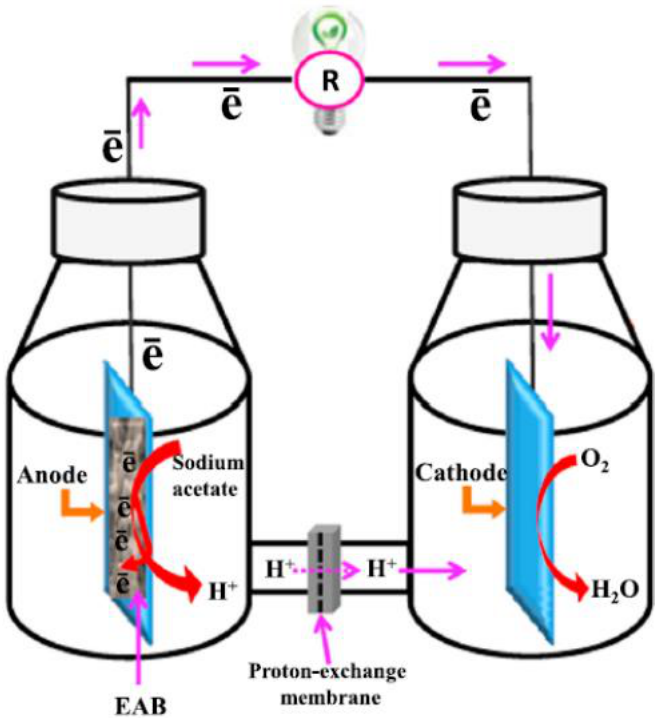
Figure 1. Schematic diagram of the microbial fuel cell [63]. Reproduced with permission from Else- vier.